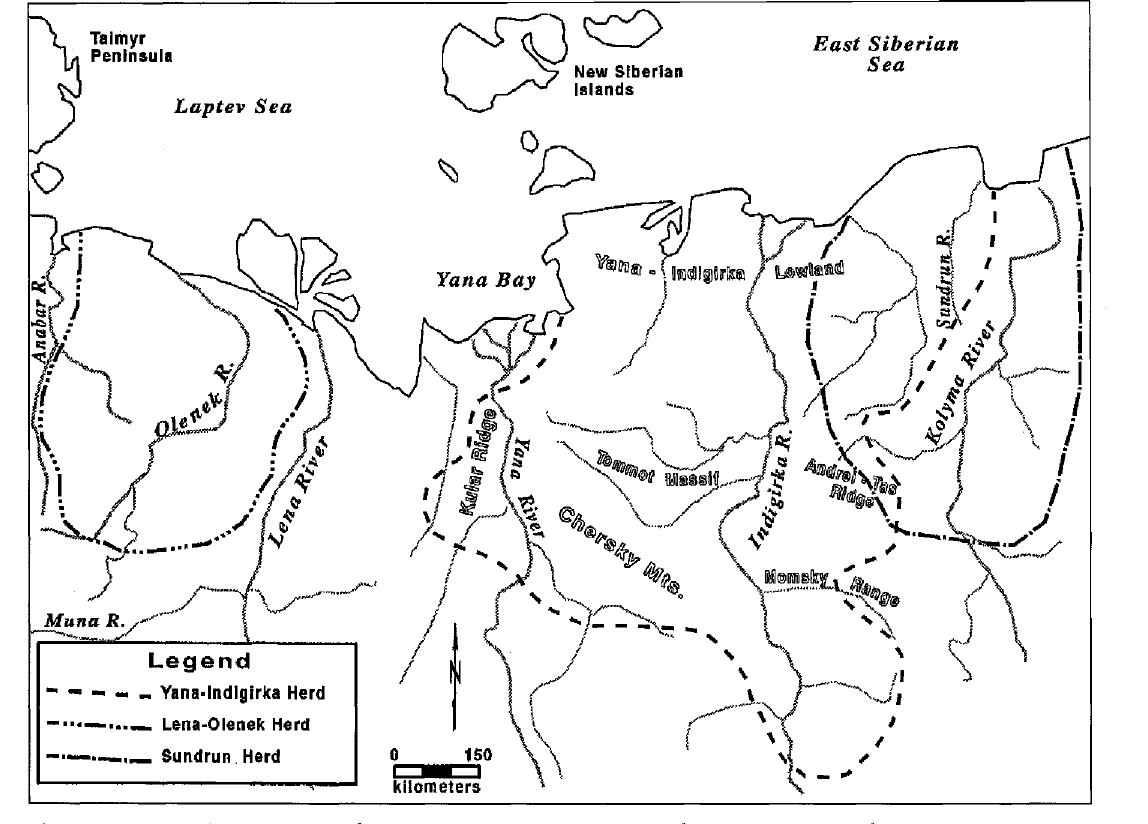
Fig. 1. Map of northern Yakutia with approximate ranges of Lena-Olenek, Yana-Indigirka and Sundrun